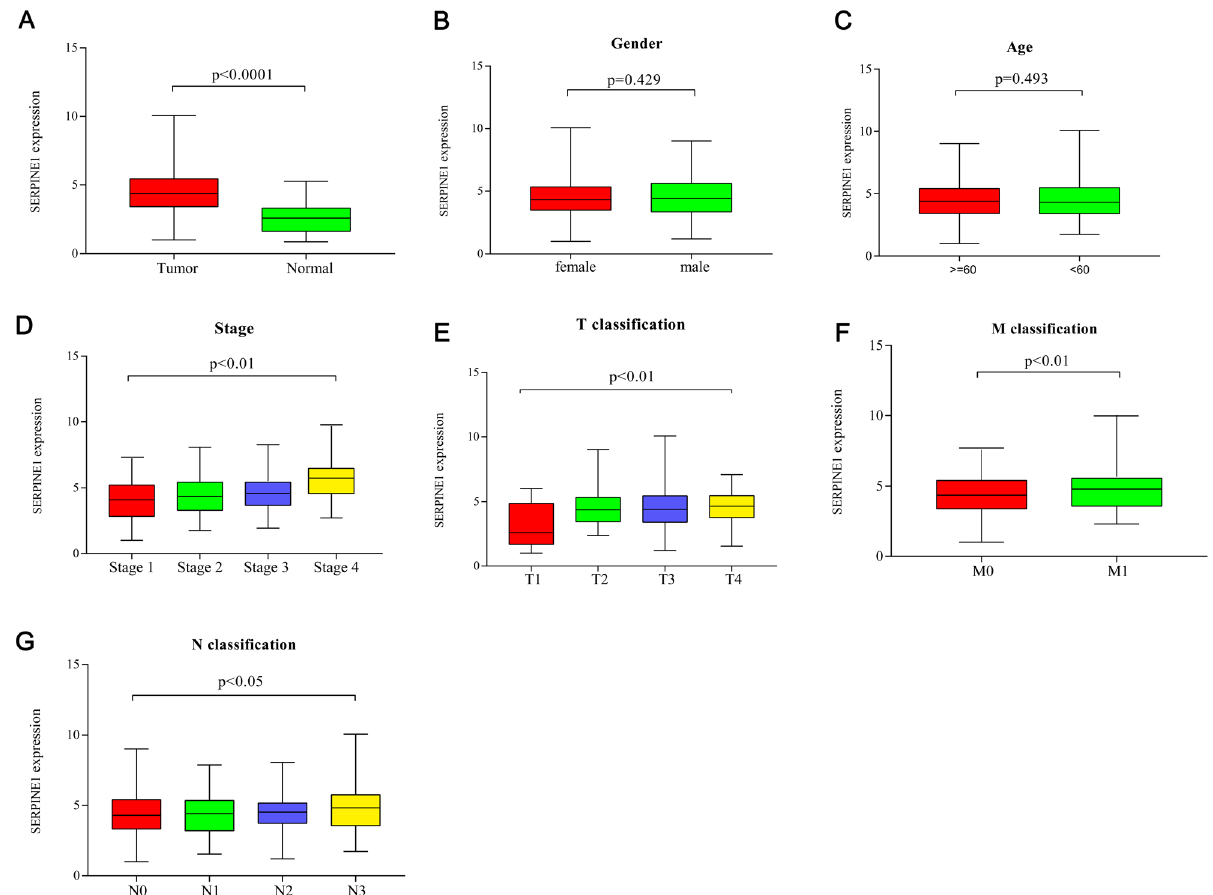
Age. ( D – G ) The correlation between the expression of SERPINE1 and clinicopathological staging. Wilcoxon rank sum or Kruskal–Wallis rank sum test served as the statistical significance